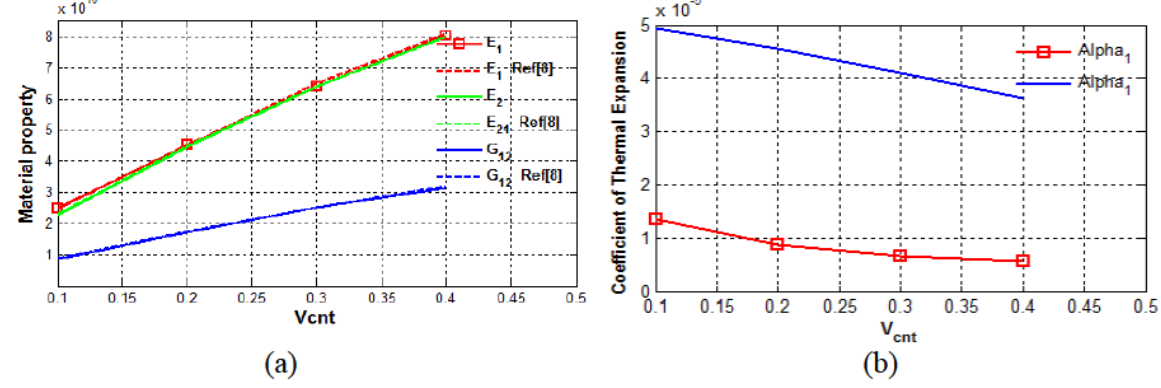
Figure 4: Effect of variation in SWCNT volume fraction on material property of three phase composite